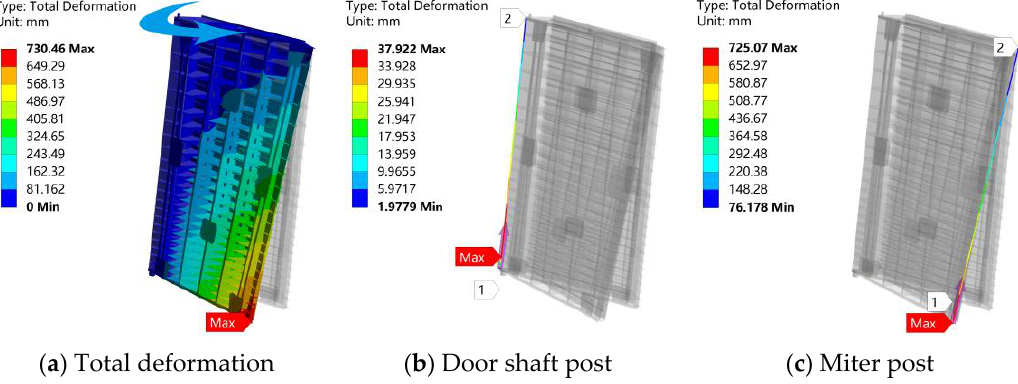
Figure 14. ( a ) Deformation of the overall structure of the backless tie rod gate, ( b ) Deformation of the door shaft column, and ( c ) Deformation of the miter column under the door-opening condition.